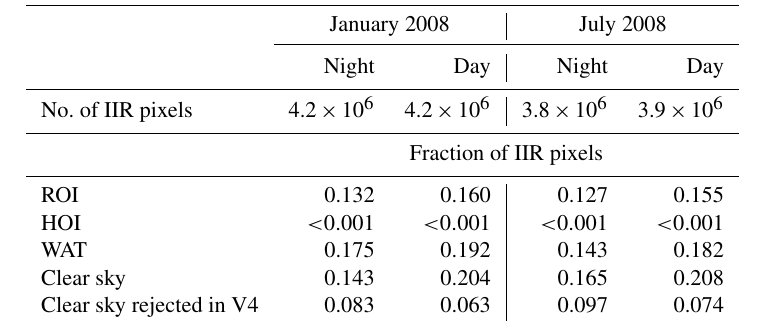
Table 1. Total number of IIR pixels, fraction of IIR pixels with only high-confidence ROI, WAT, and HOI layers in the column and no single-shot cleared clouds for retrievals with background radiance from the ocean surface between 60 ◦ S and 60 ◦ N, and fraction of clear-sky pixels.